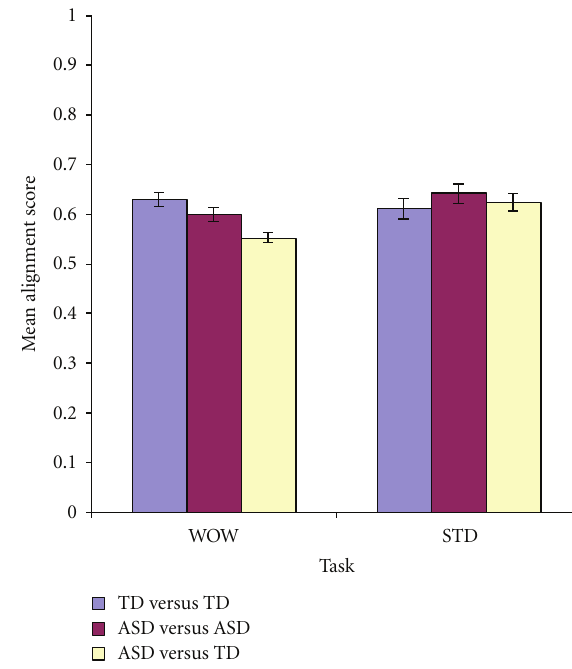
Figure 2: Mean alignment scores ( ± SE) for the three types of match for each task